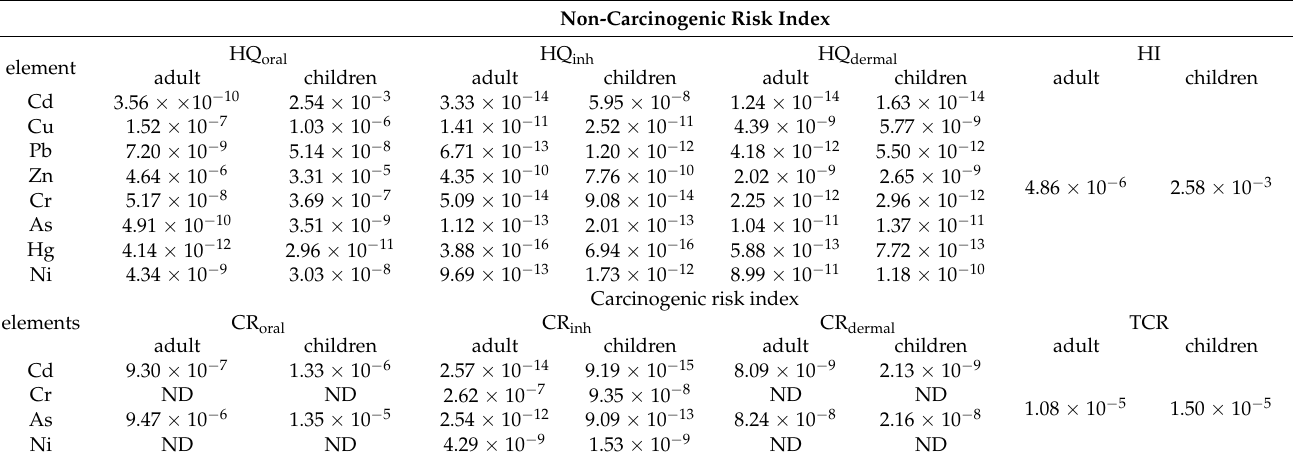
Table 2. Non-carcinogenic risk index and carcinogenic risk index in soil planted with hulless oats. Non-Carcinogenic Risk